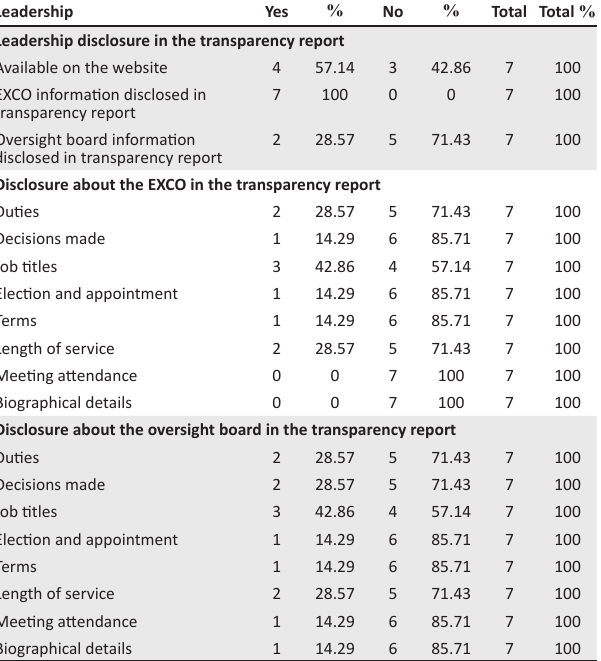
TABLE 2: Findings on the leadership principles.